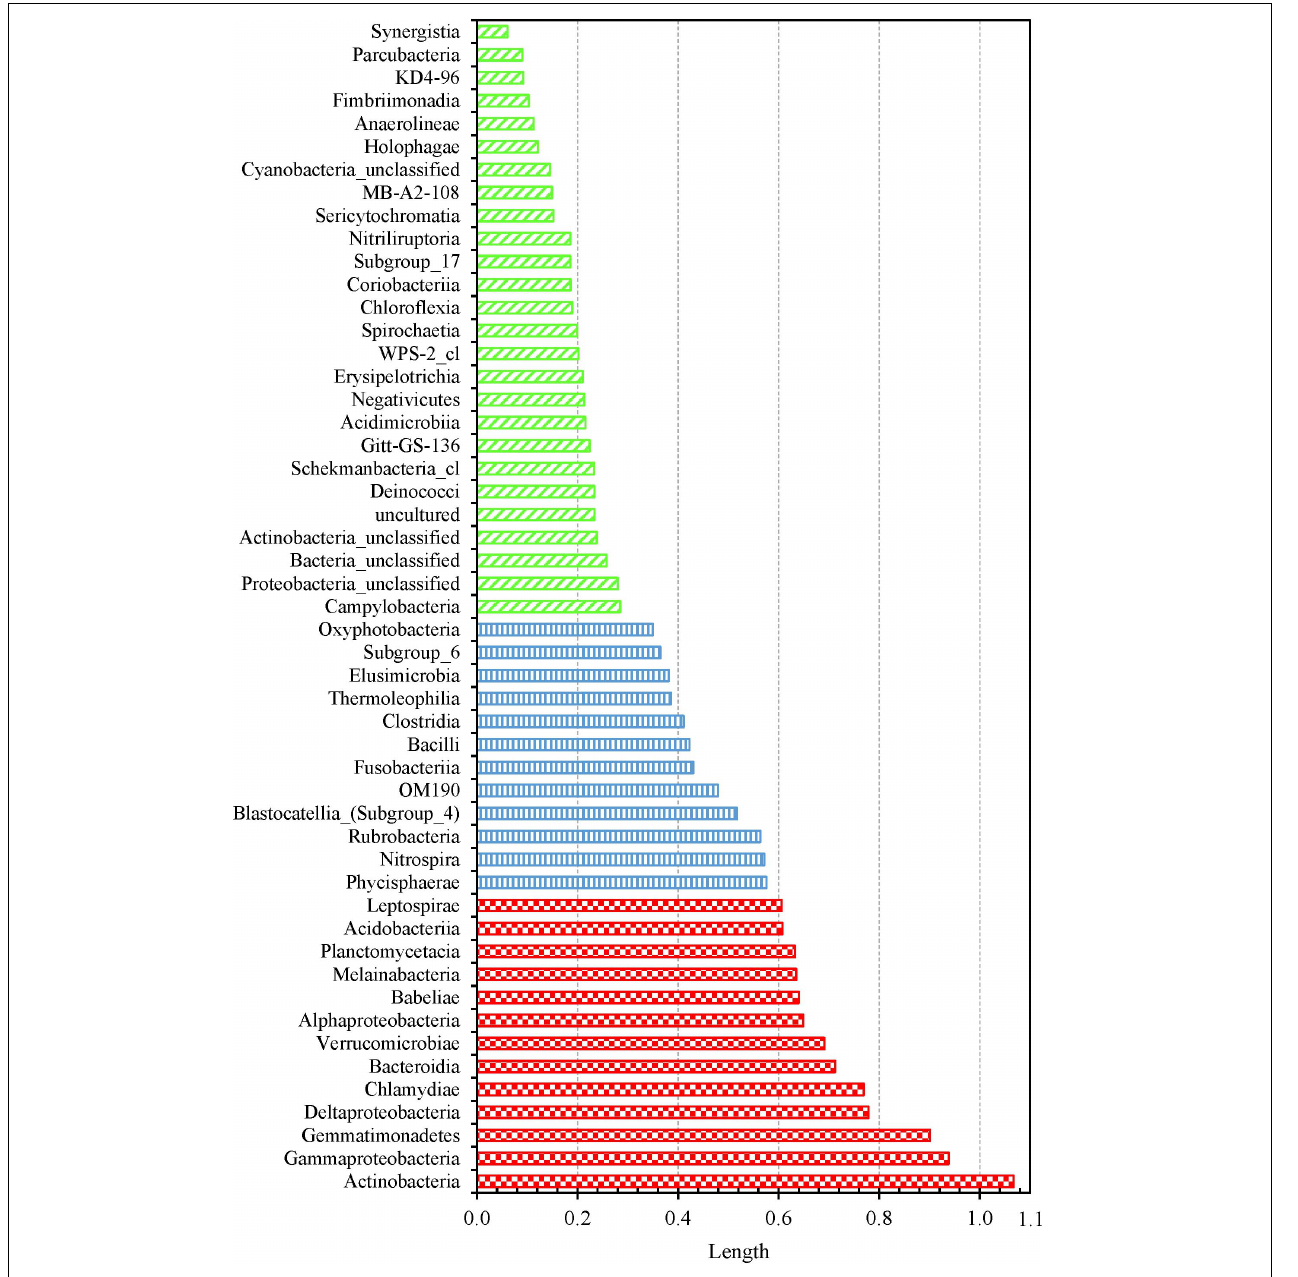
FIGURE 6 | Shifting of water samples in the 3D NMDS space by bacterial classes. Fifty one classes were identified from all water samples. Classes with lengths greater than 0.6, between 0.3 and 0.6, and less than 0.3: red large checker board, blue vertical stripes, and green wide upward diagonal stripes, respectively.